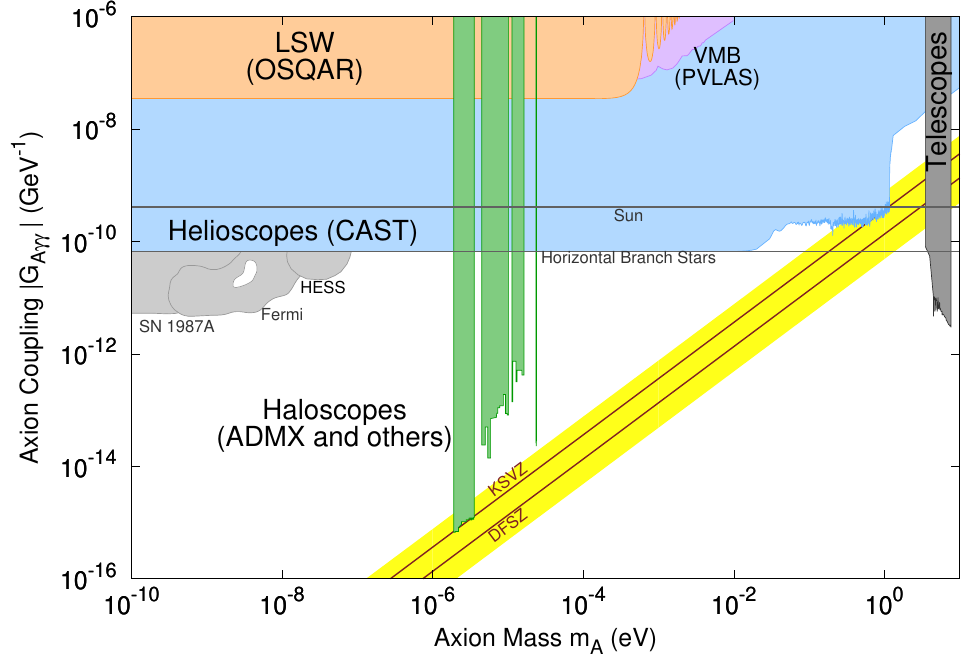
Figure 21. The current constraints on QCD axions and ALPs. The yellow band represents the various models of QCD axions. The constraints from the Sun and the Horizontal Branch stars are the regions above the corresponding lines. The regions ruled out by various experiments are indicated by the colored areas. The figure is reproduced from